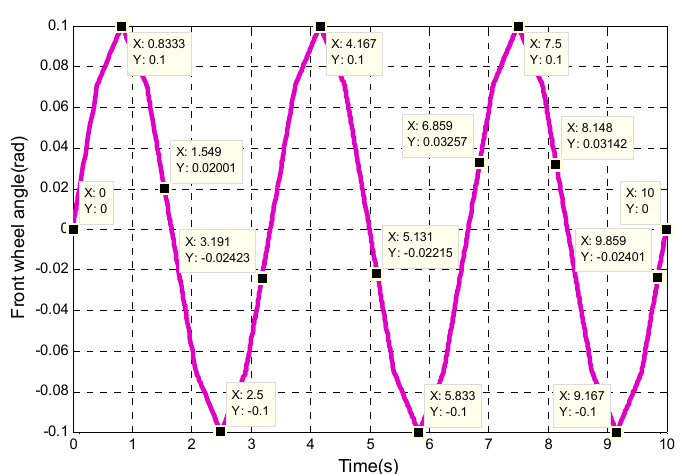
Figure 20. The sinusoidal input of the front wheel angle.